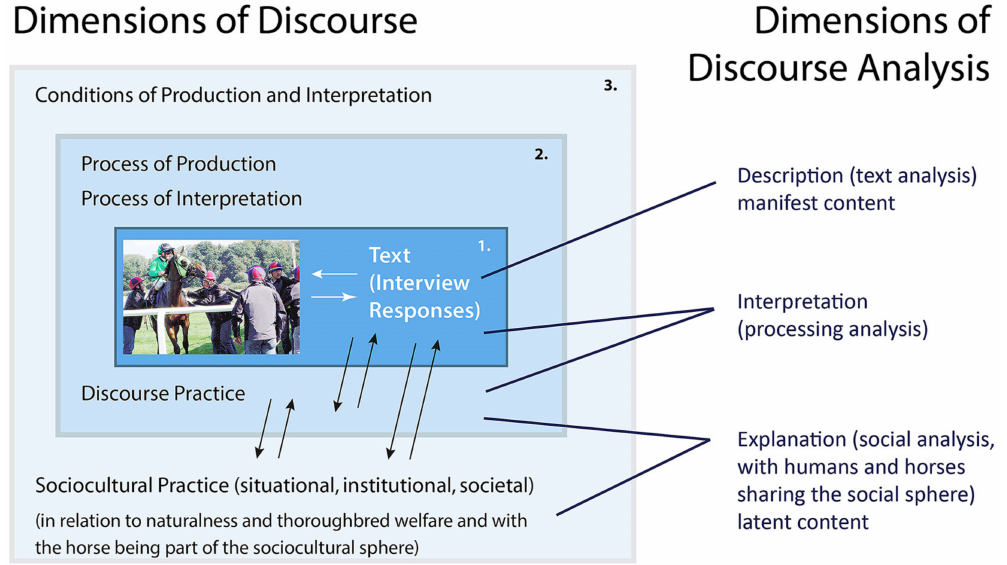
Figure 5. Dimensions of the discourse and discourse analysis (adapted from Janks [94] and Fairclough [96]) as they relate to the research process in this current